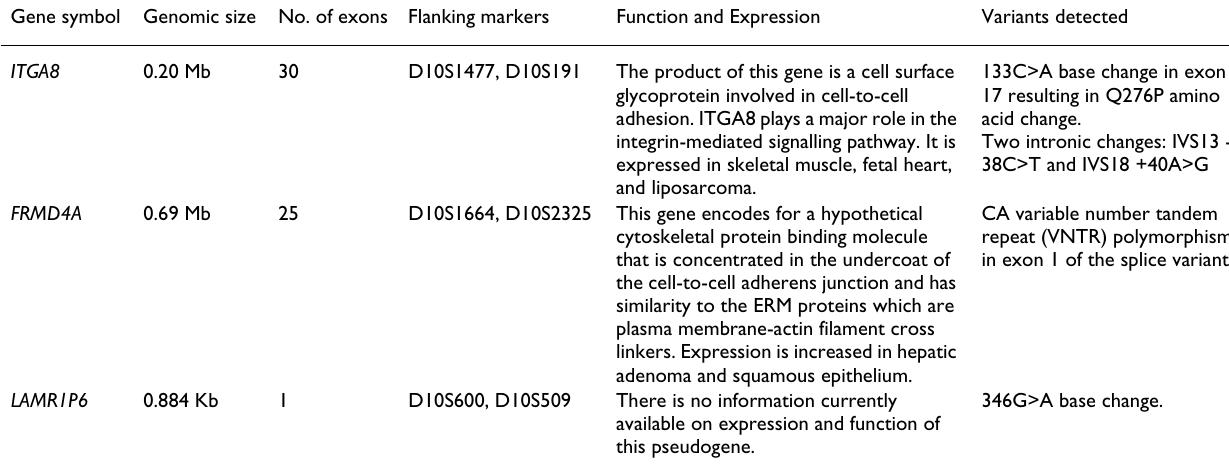
Table 4: General information on candidate genes selected for mutation screening. Gene symbol Genomic size No. of exons Flanking